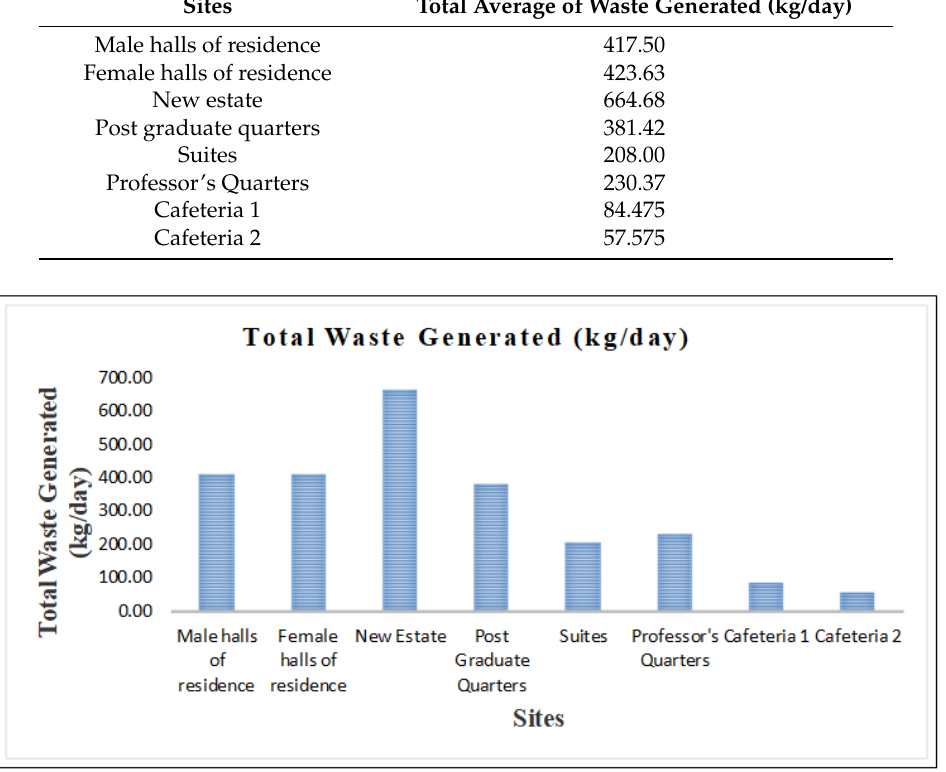
Figure 4. Comparison of total weight generated in selected areas. Table 9. Economic value from recycling waste materials.